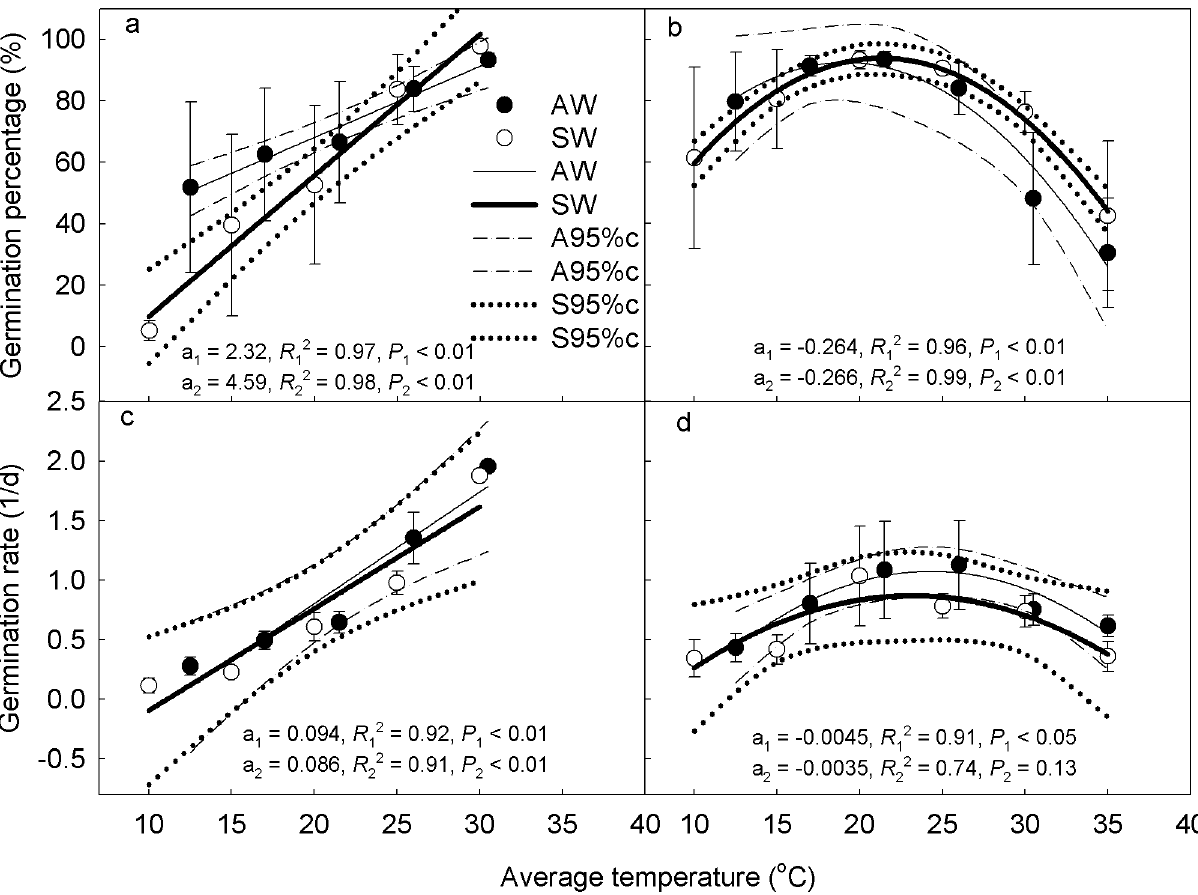
Figure 3. Germination percentage (a, b) and germination rate (c, d) changes of C 4 (a, c) and C 3 (b, d) species with increasing average temperature in the AW and SW temperature regimes. The relationship between C 4 species and the average temperature is fitted by linear equation; the relationship between C 3 species and the average temperature is fitted by polynomial equation. Dash-dot lines represent 95% confidence of AW temperature regime and dotted lines represent 95% confidence of SW temperature regime. a 1 , R 12 , P 1 represent the parameter, coefficient of determination and probability for the fitting in the AW regime and a 2 , R 22 , P 2 represent the parameter, coefficient of determination and probability for the fitting in the SW regime.